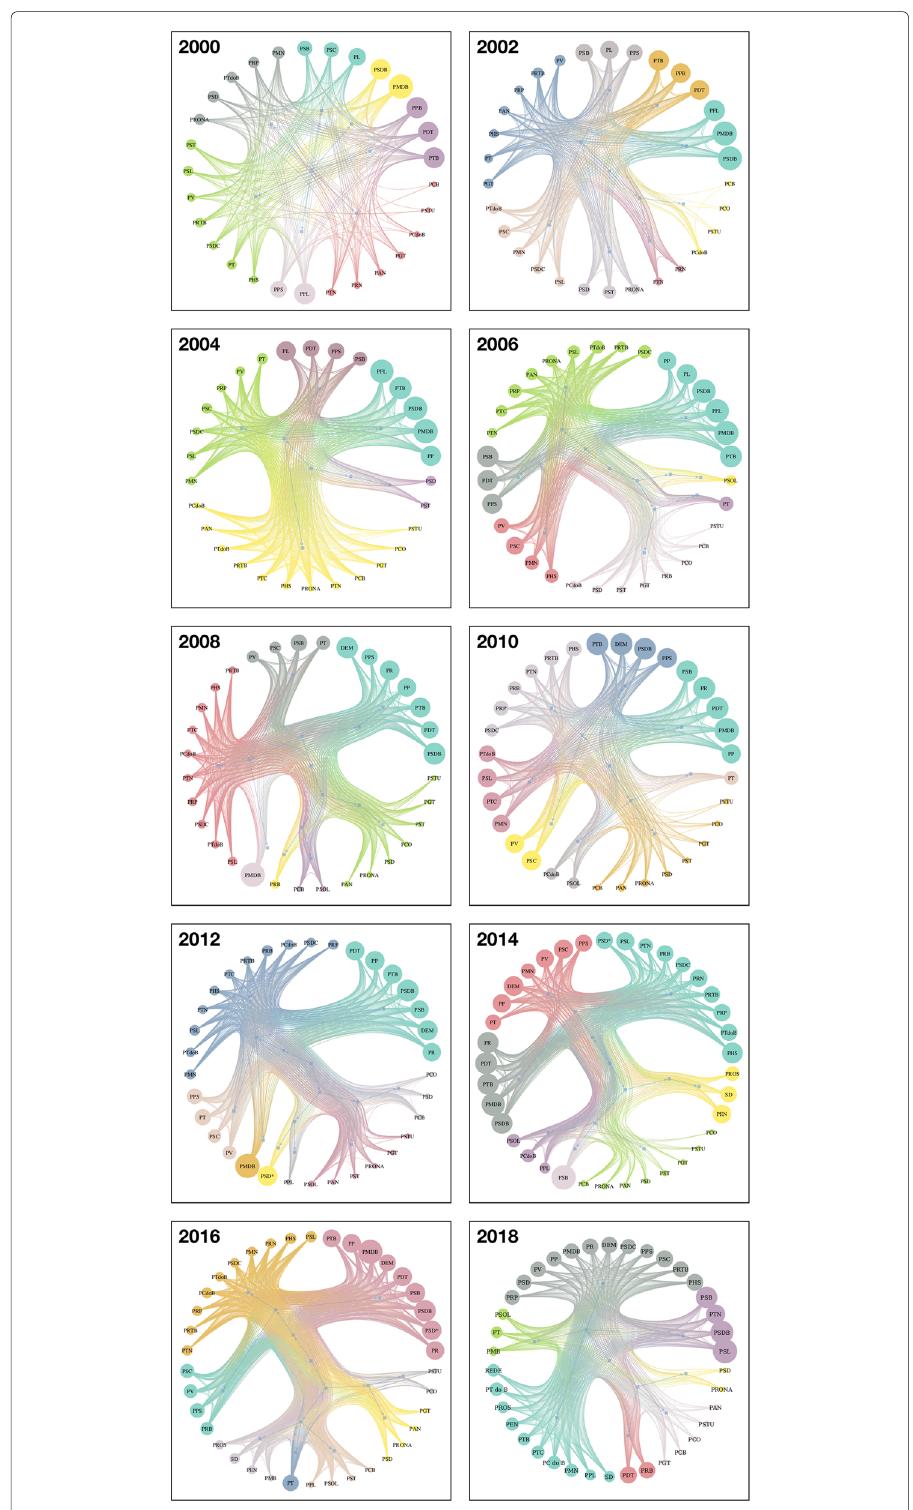
Fig. 4 Networks of inter-parties movements for the elections in the period from 2000 to 2018. The nodes’ colors correspond to their communities while sizes are proportional to the nodes’ total weighted degree. In the first year, the network has low density and there is scant evidence of structure. As more data is added the structure of party clusters became